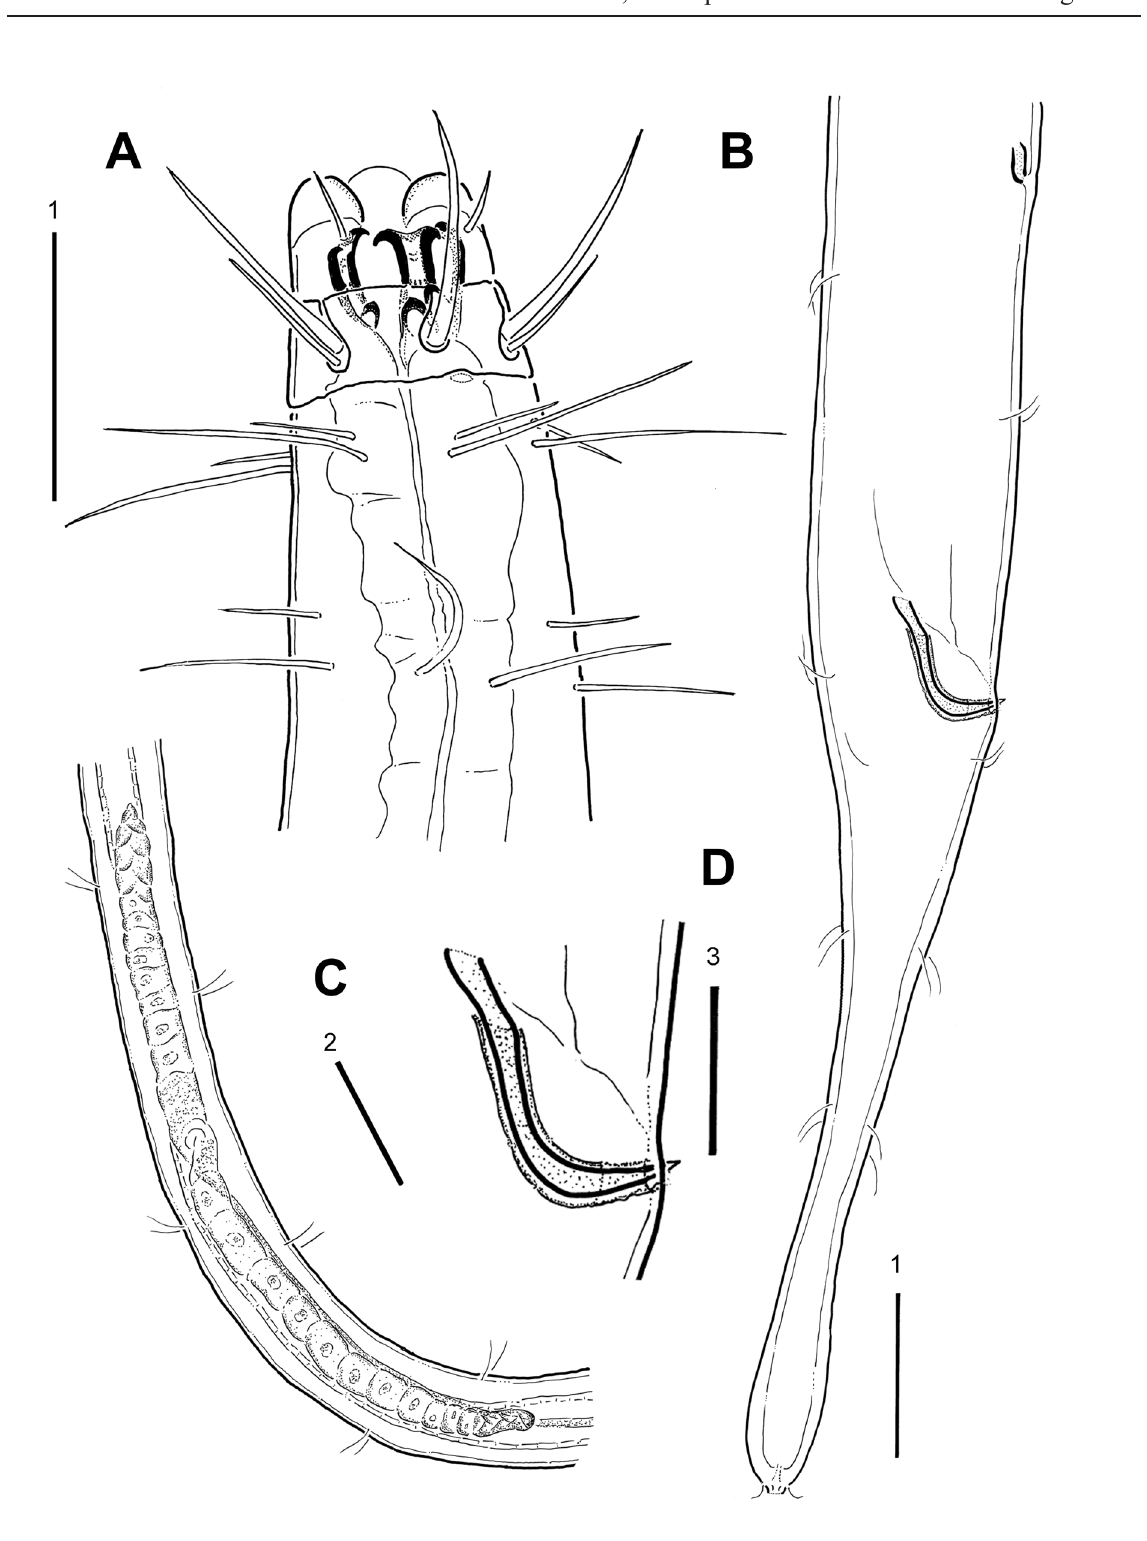
Fig. 3. Mesacanthion longigubernaculum sp. nov., ♂, holotype (CNP-NEM 27442). A . Cephalic sense organs on anterior end. B . Posterior end, showing copulatory apparatus and precloacal supplement organ. C . Gonads. D . Copulatory apparatus, spicules and gubernaculum. Scale bars: 1 = 20 μm; 2 = 100 μm; 3 = 10